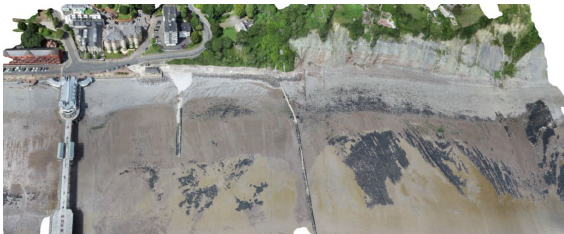
Figure 6 – 2015 DSM with 2016 Orthomasaic. On top is the 2015 DSM showing the areas of cut and fill and the 2016 Orthomosaic below. The red segments on the DSM are the areas of materials loss and the blue segment are the areas of material gains.